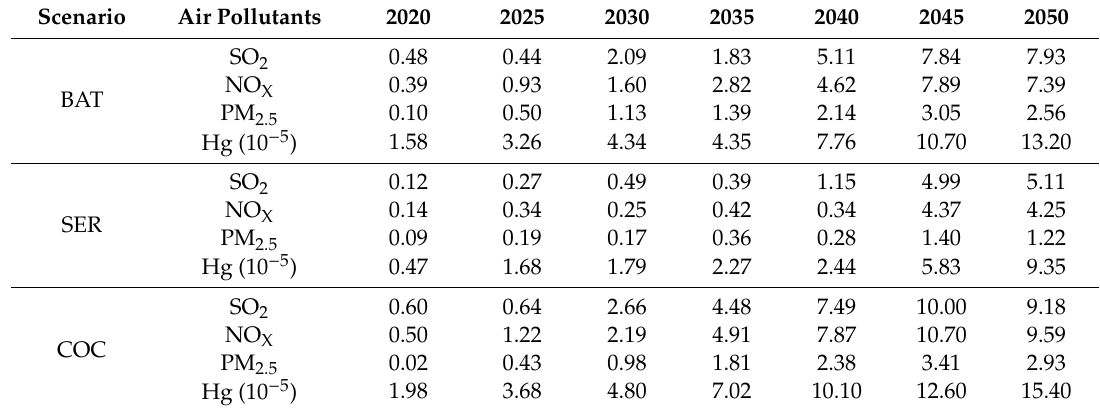
Table 4. Emission reduction potential in power industry (Mt).